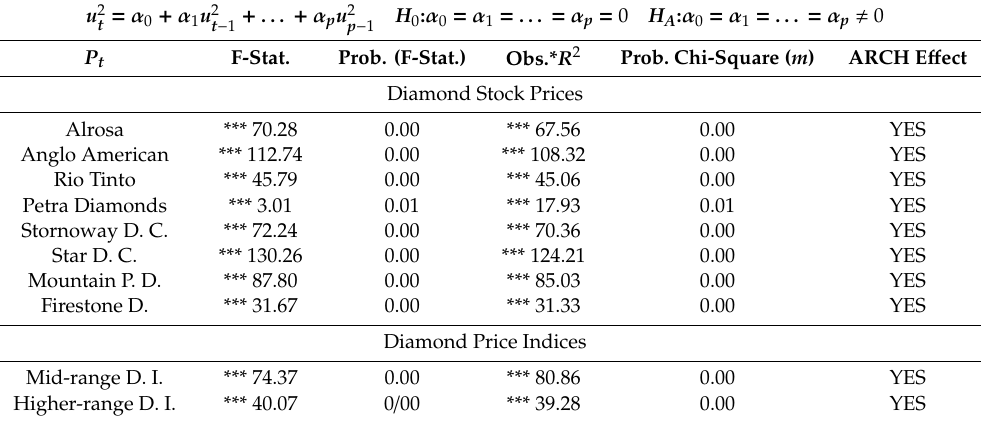
Table 6. ARCH LM test statistics for diamond stock prices and diamond indices.